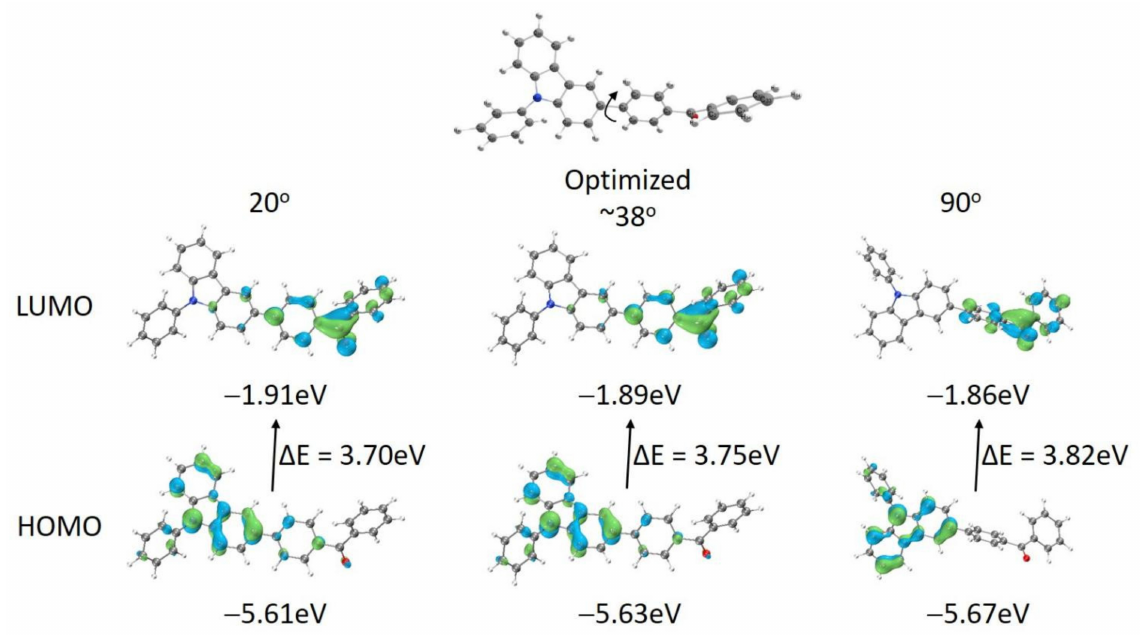
Figure 4. Frontier molecular orbitals (HOMO and LUMO) in the ground state of BP-3-Cz with different twist angles between the carbazole plane and benzophenone